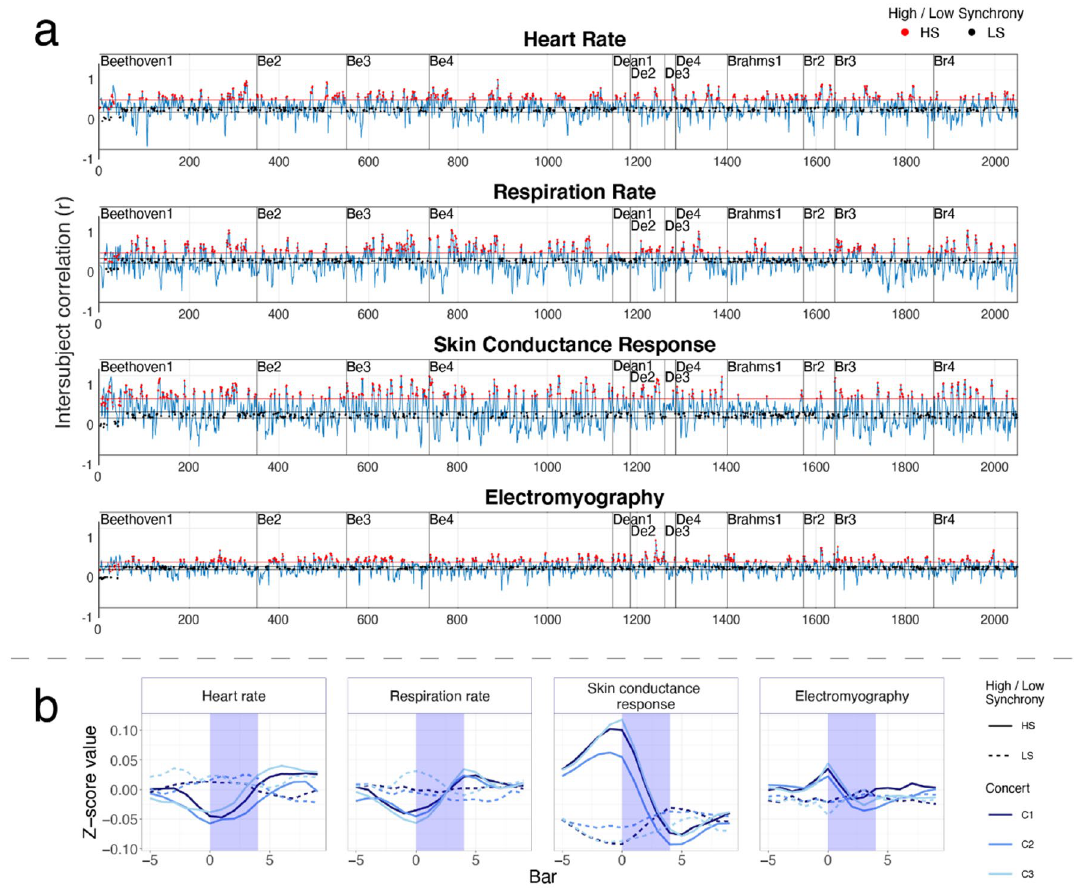
Figure 1. Inter-subject correlation (ISC) across concerts and bars of high- and low-synchrony. ( a ) ISC time courses for heart rate (HR, row 1), respiration rate (RR, row 2), skin conductance response (SCR, row 3), and electromyography activity of zygomaticus major (‘smiling’) muscle (EMG, row 4) for concert 1. Moments of high and low synchrony are marked with red and black dots, respectively. Red lines signify the 20th percentile threshold, while black lines signify the 20th percentile centred around r = 0. ( b ) Average high synchrony (HS) versus low synchrony (LS) of each physiological measure and concert. Moments of high and low synchrony are marked with solid and dotted lines, respectively. Four musical bars precede (− 4 to 0) and follow (4–8) correlation windows (highlighted in blue box) with high ISC value starting from the first bar of correlation (bar0) to last bar of correlation window